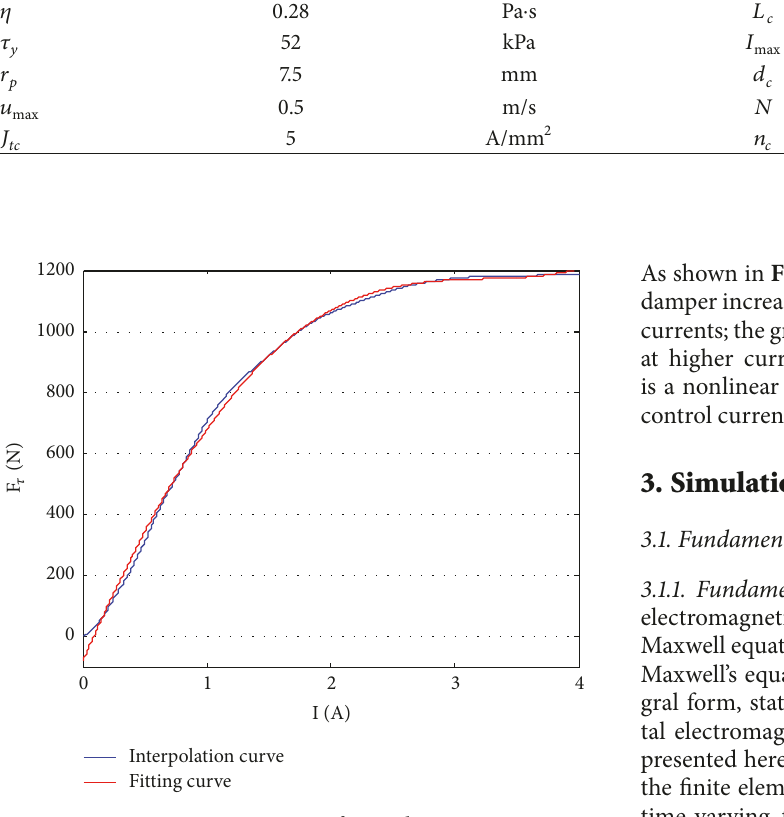
Figure 8: 𝐹 𝜏 − 𝐼 curve of MRF